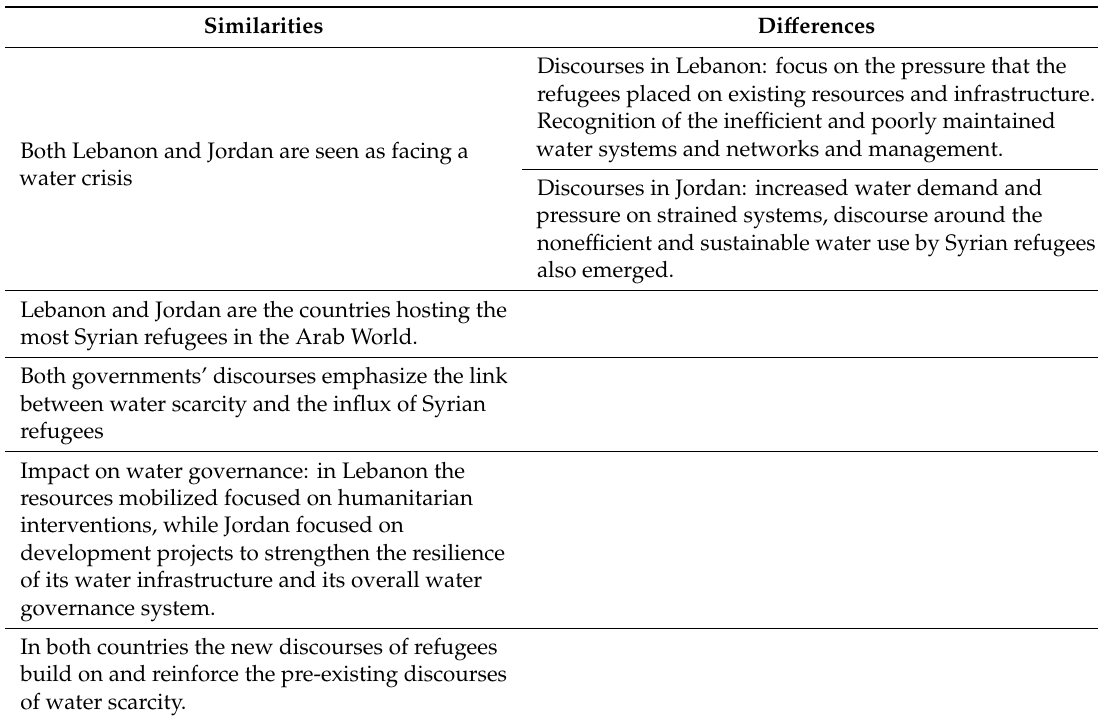
Table 2. Similarities and di ff erences Lebanon and